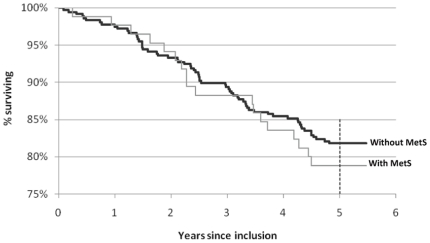
Survival curve of the elderly people by metabolic syndrome, up to 5 years.